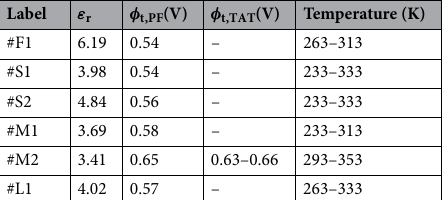
Table 2. The ε r , φ t,PF and φ t,TAT values calculated by fitting the PF and TAT plots and the temperature ranges over which the PF and TAT mechanisms predominantly determined the reverse leakage